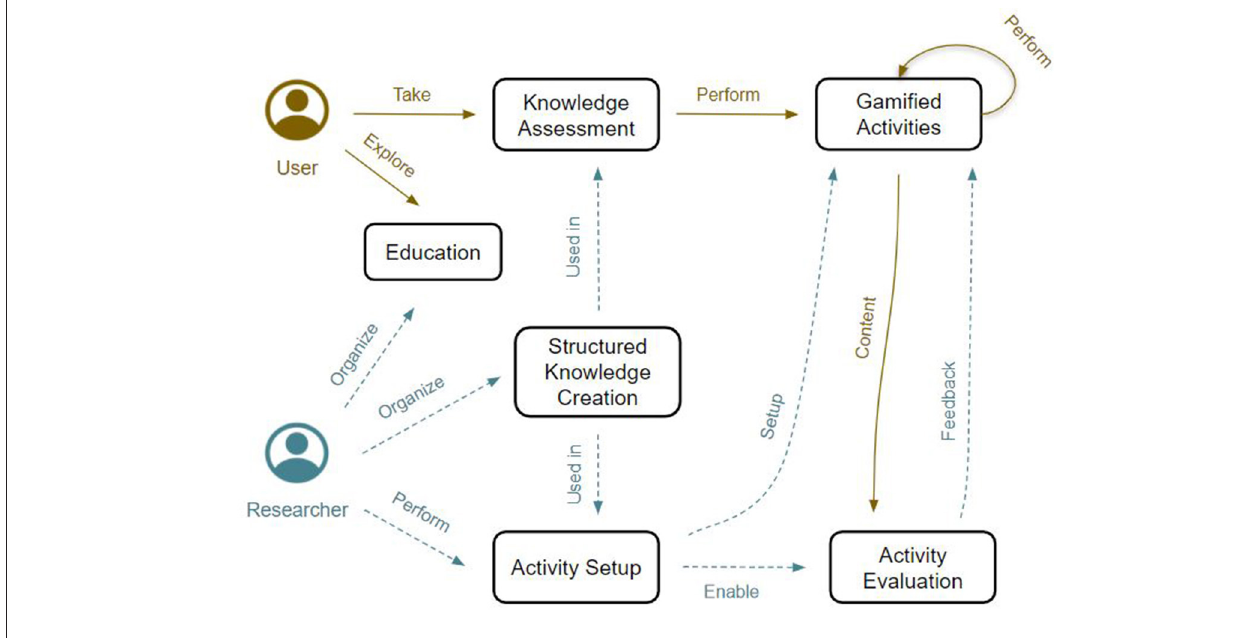
FIGURE 1 | Interaction flows of researchers (dashed cyan arrows) and users (orange plain arrows) with the activities devised within our framework, as described in Section 3. Researchers organize users’ knowledge and set up activities to collect data. As users engage with such activities, they provide Content to researchers. In turn, researchers give the user feedback about the activity they performed. Such feedback aims to improve users’ understanding of the activity itself, the knowledge and the context provided within